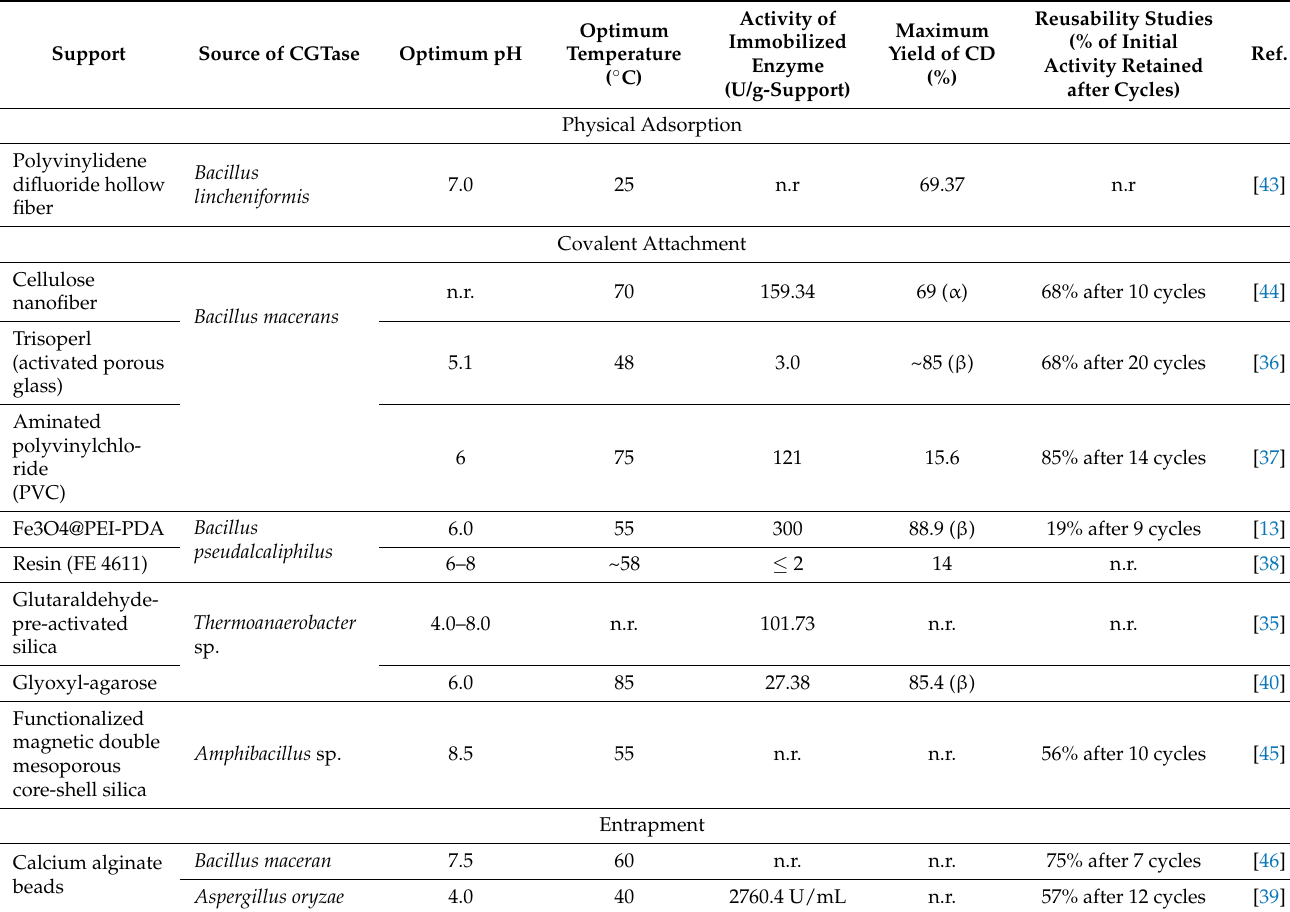
Table 2. Properties of CGTase immobilized on different supports for cyclodextrin (CD)